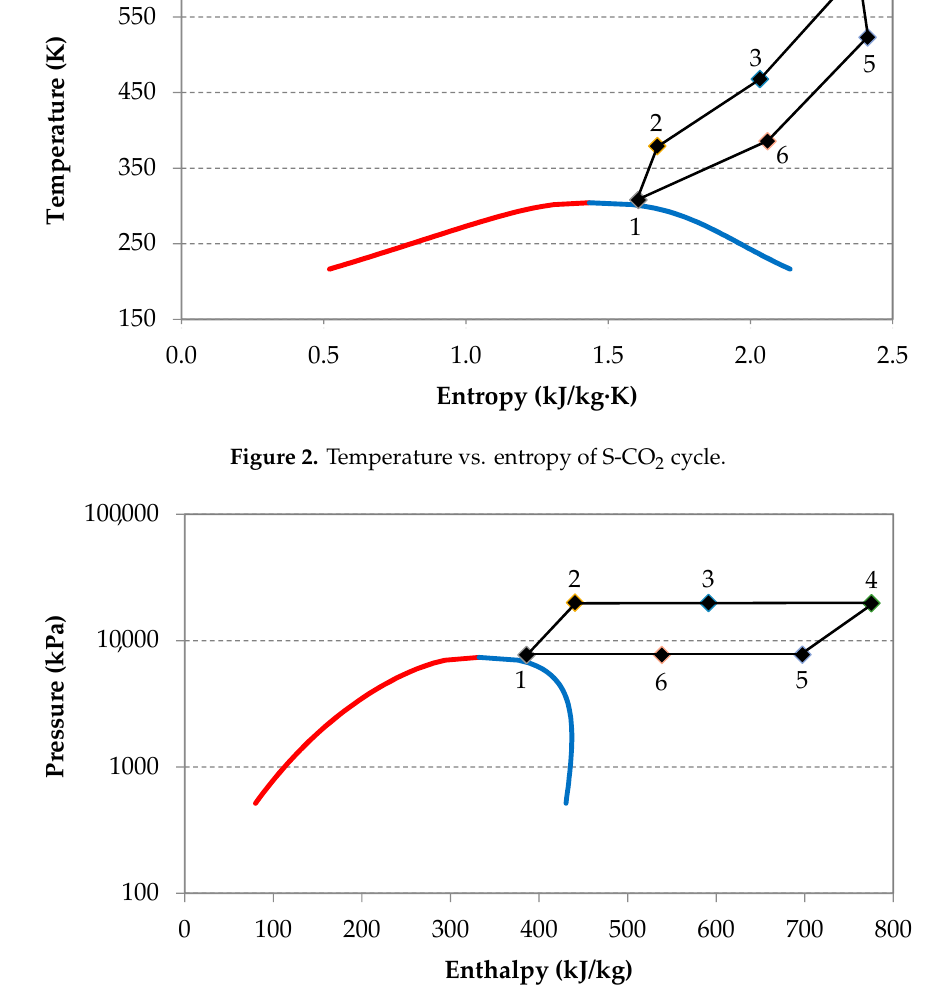
Figure 3. Pressure vs. enthalpy of S-CO 2 cycle.